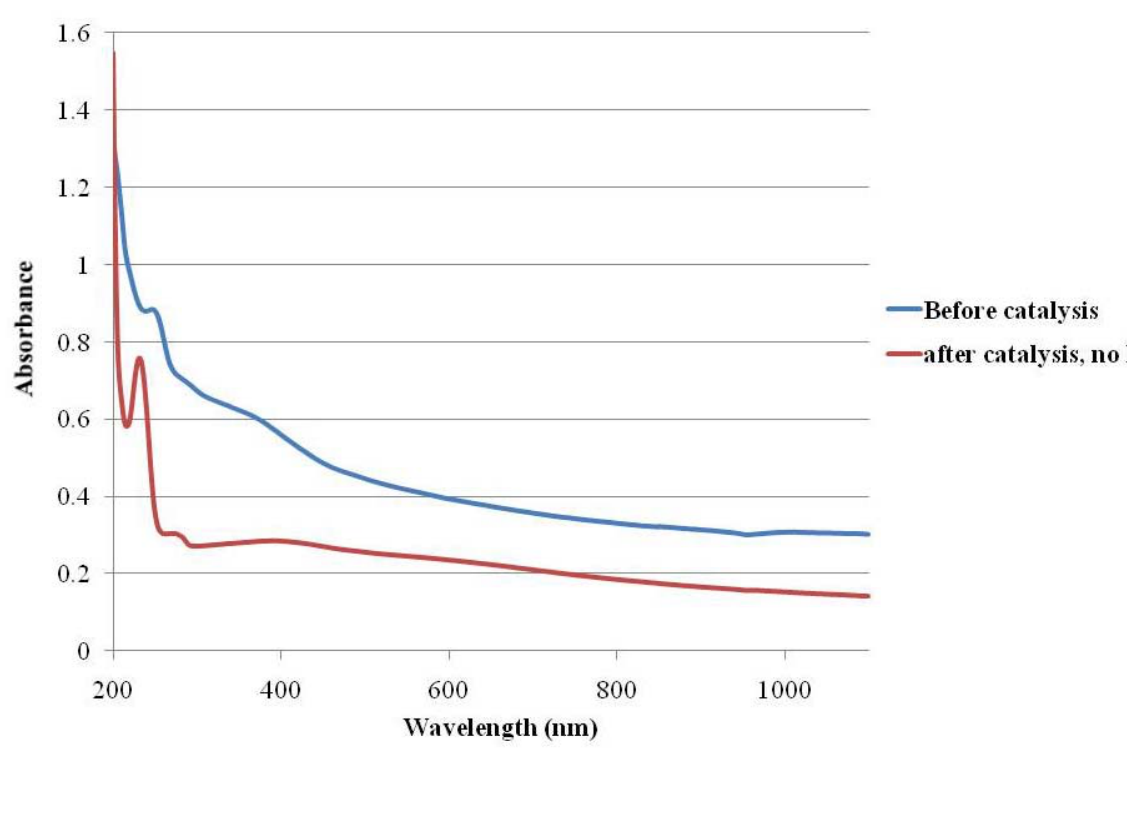
O :PVP/Au in milliQ water, both before and after the 3 4